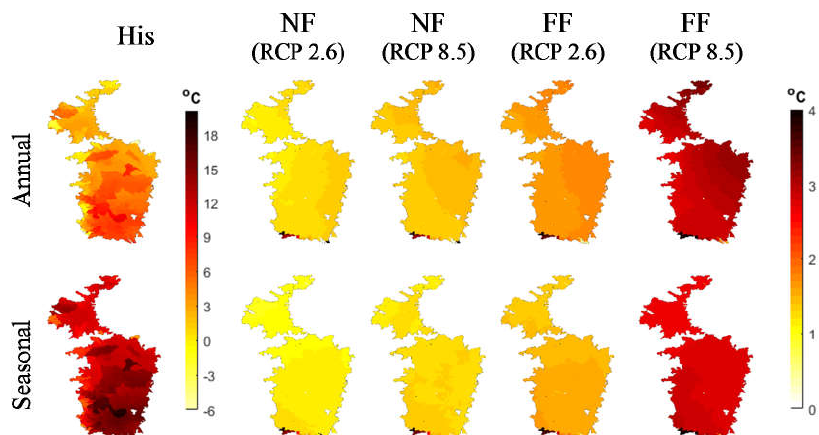
Figure 4. Spatial distribution of mean seasonal and annual temperature and their projected changes (°C) in the future under RCP 2.6 and 8.5, where His indicates historical period (1983–2007), NF indicates near future (2010–2034) and FF indicates far future (2040–2064).